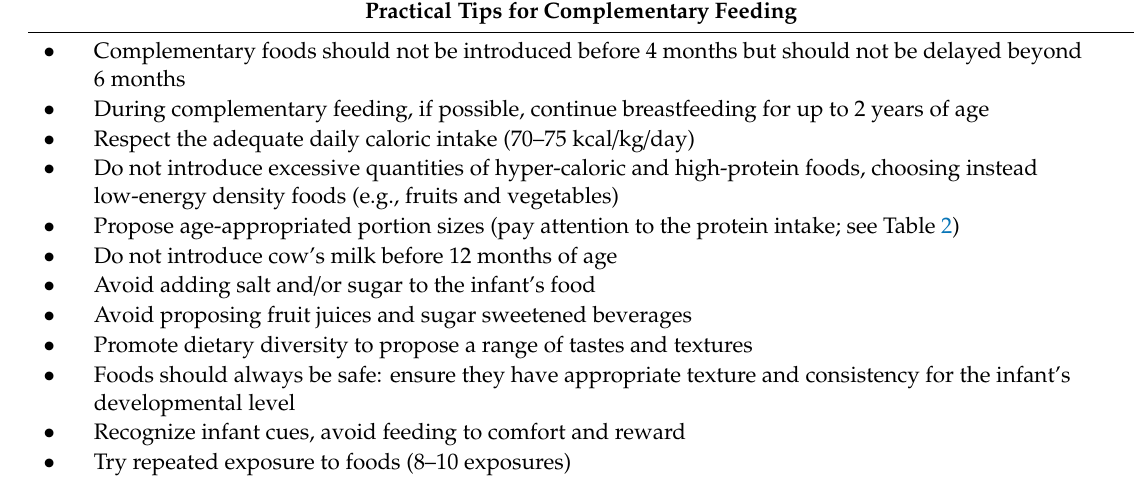
Table 1. Practical tips for healthy complementary feeding: “aiming at a healthy future”. Practical Tips for Complementary Feeding